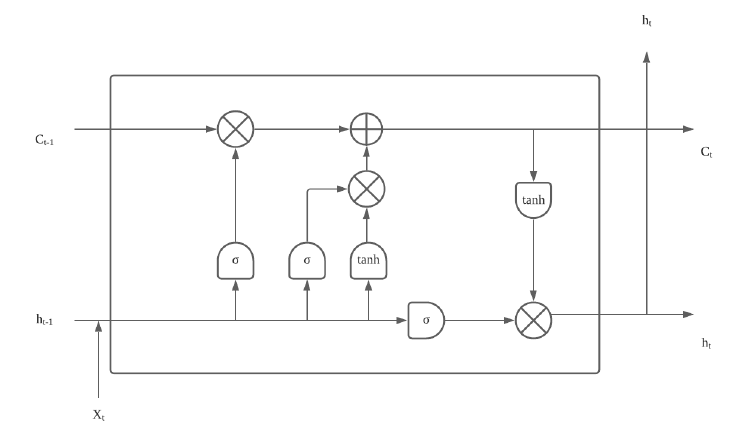
Figure 3. The LSTM